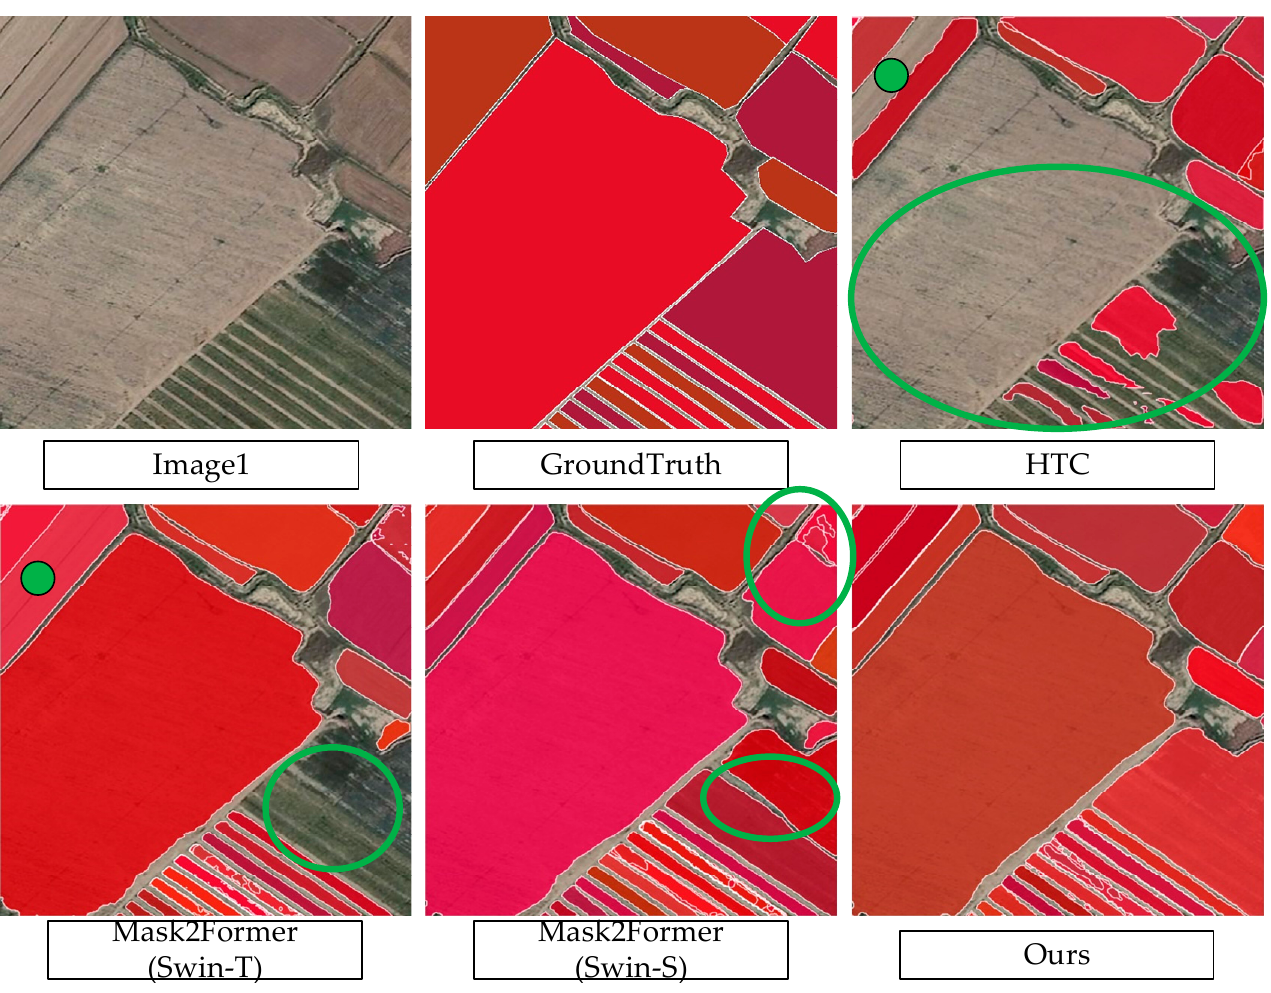
Figure 7. Visualization results of different models on fields with large-scale transformation. Green circles highlight areas of poor extraction.